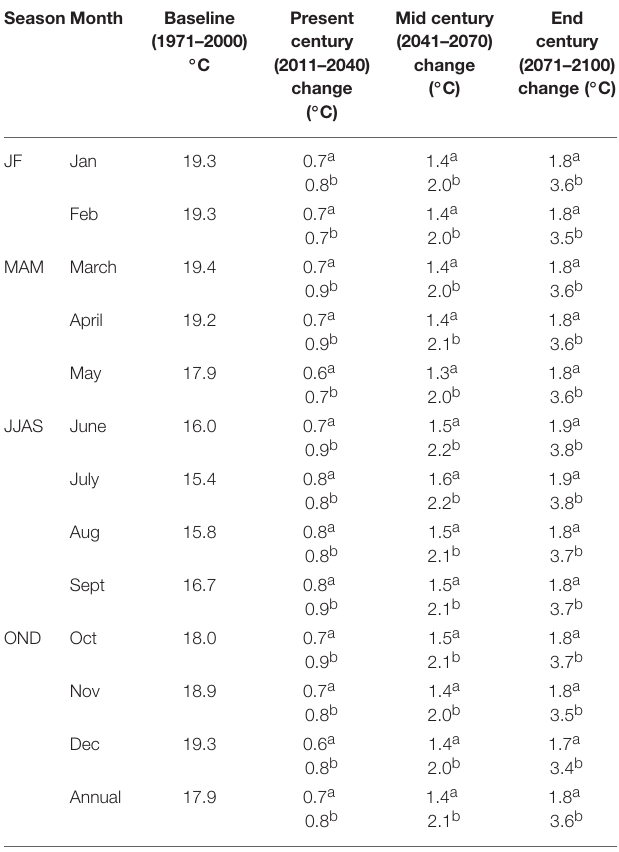
TABLE 7 | Projected changes in minimum temperature for